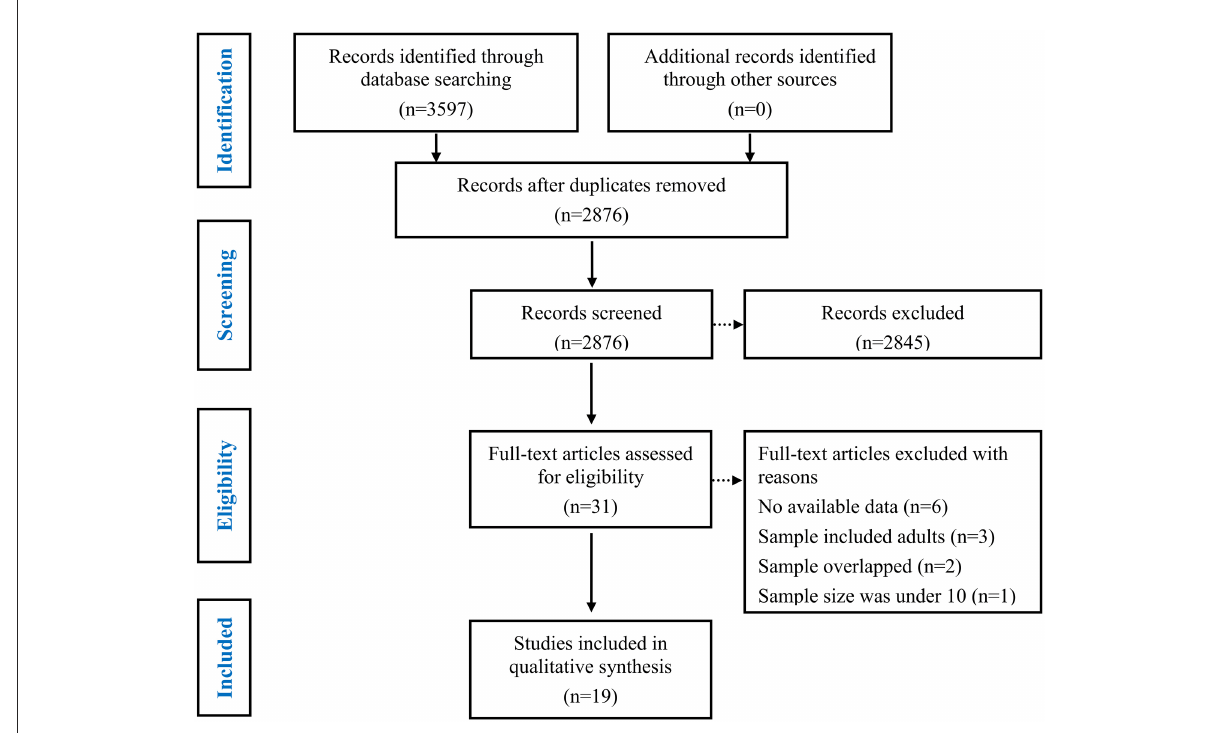
FIGURE1 PRISMA flowchart of study screening and selection